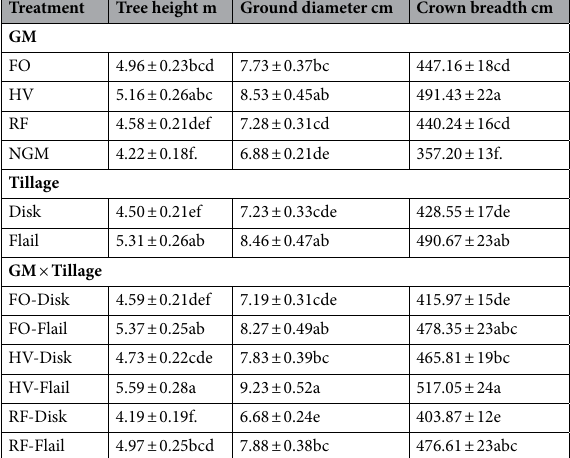
Treatment Tree height m Ground diameter cm Crown breadth